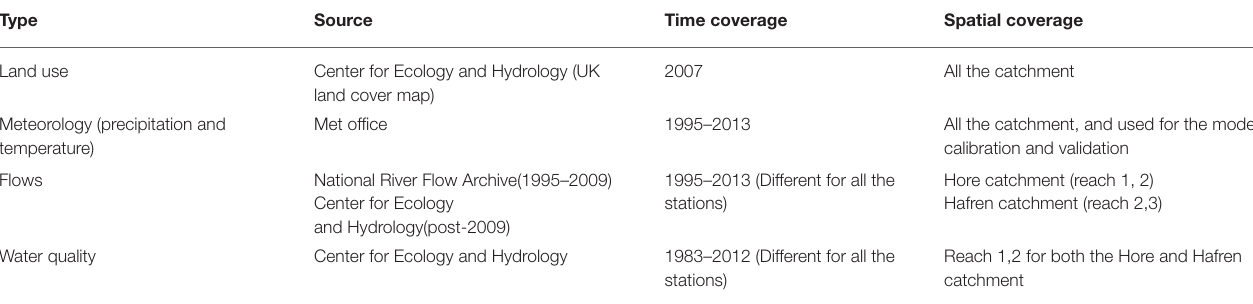
TABLE 2 | Data used in this study for model setup and